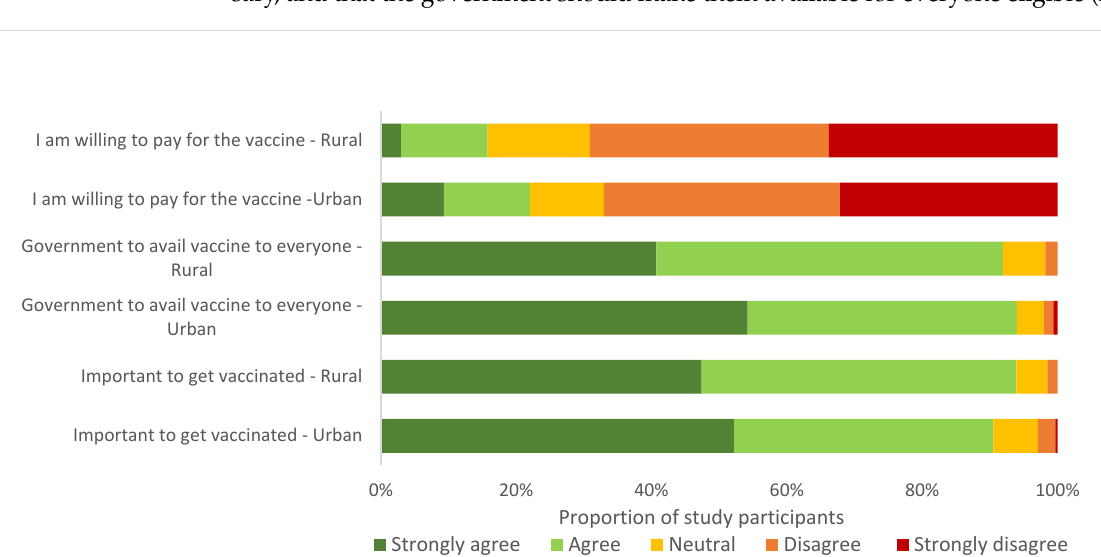
Figure 4. Participants’ attitudes towards the COVID-19 vaccine.